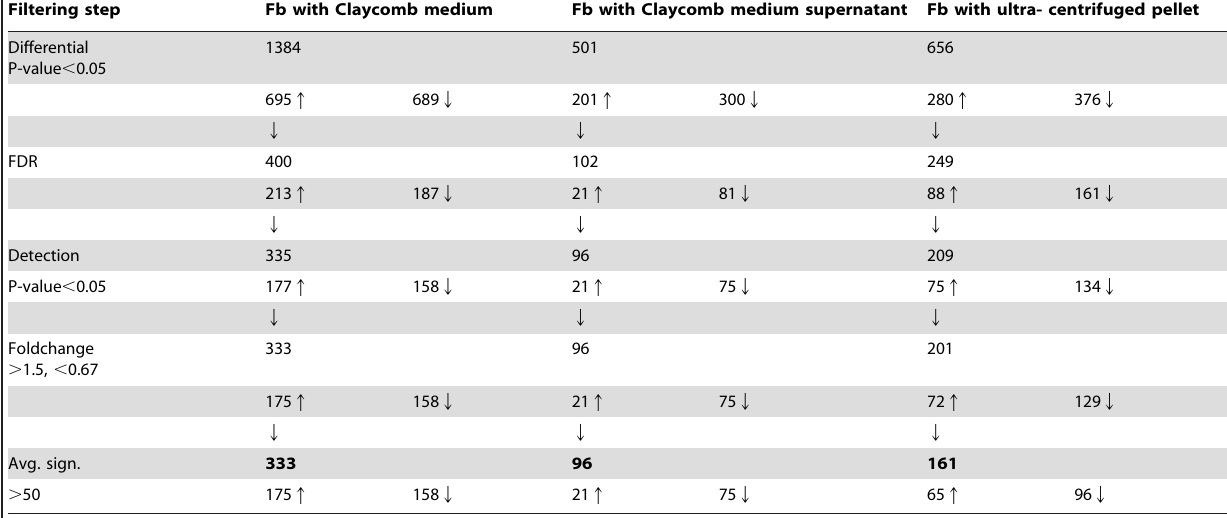
Table 1. Filtering of differentially expressed genes.